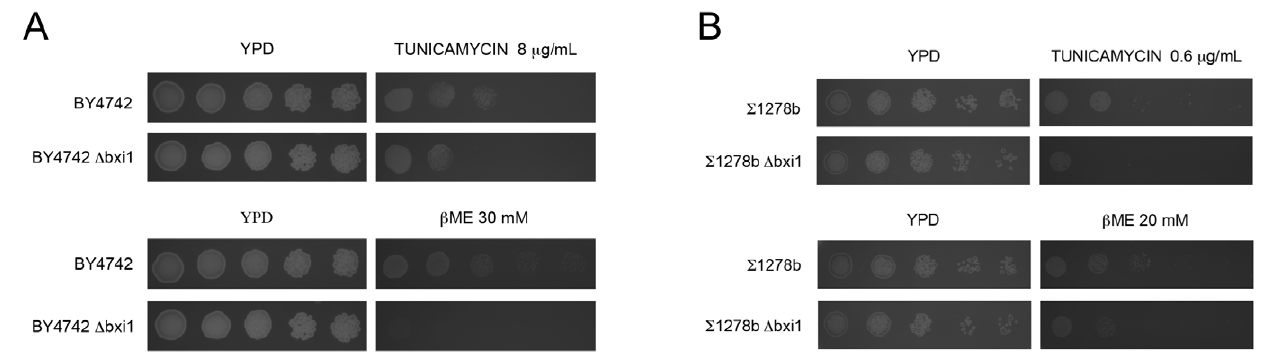
Figure 5. Yeast cells lacking BXI1 are sensitive to b -mercaptoethanol and tunicamycin. Wildtype and D bxi1 cells from the BY4742 and S 1278b strain backgrounds were cultured in rich YPD media overnight. They were then resuspended in fresh media and allowed to reach exponential phase (an approximate OD 600 value of 0.4). For each strain, a series of 10-fold dilutions was then prepared in water over a range of concentrations from 10 2 1 to 10 2 5 relative to the initial culture. Spots of 5 m l from each dilution series were then plated on the indicated media and cultured at 30 u C for 2 days. Plates supplemented with drugs were poured and used on the same day. All spot assays were repeated at least three times and a representative experiment is shown.